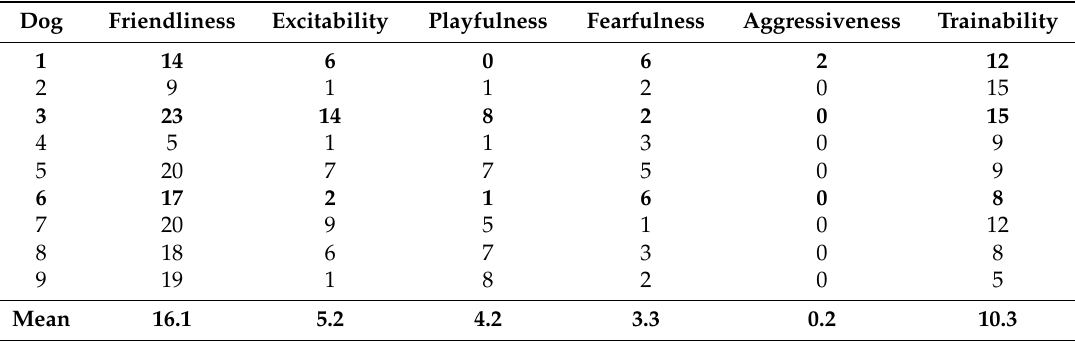
Figure 2. Strongly correlated relationship between the proportion of time (%) spent ‘scenting’ and the dogs’ sensitivity scores with Handler 1 and 2. Table 3. The dogs’ behaviour assessment scores for Friendliness (score/23), Excitability (score/23), Playfulness (score/17), Fearfulness (score/24), Aggressiveness (score/24), and Trainability (score/15). The dogs who performed well for both handlers are in bold.